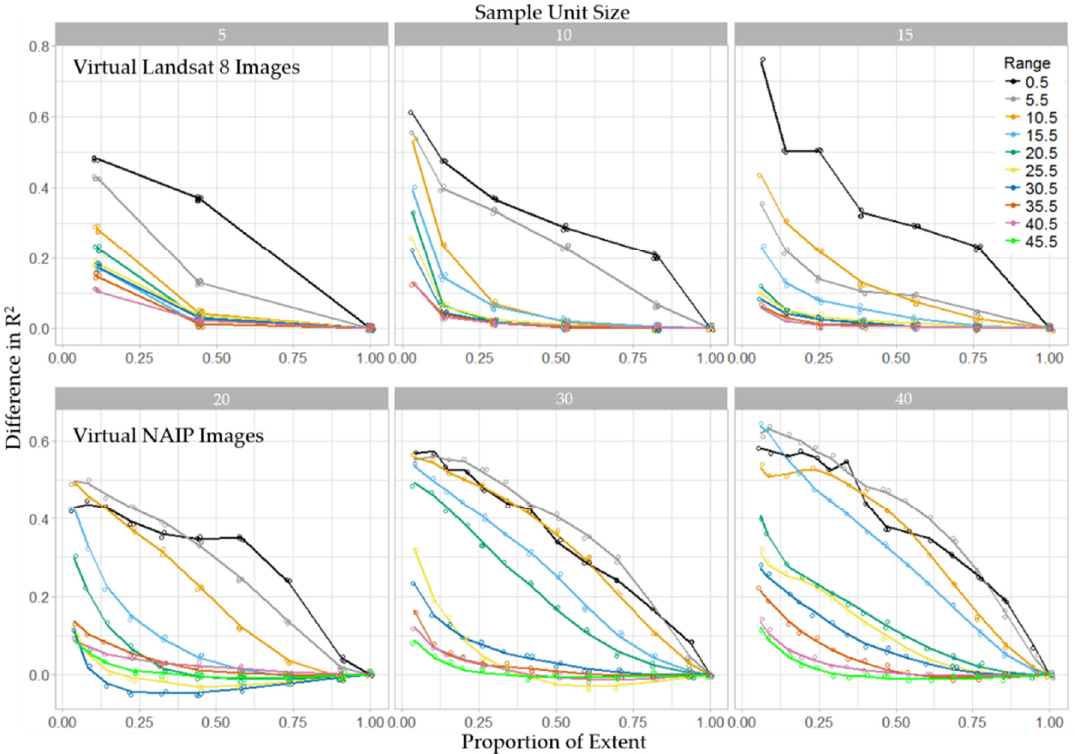
Figure 8. Reduction in the proportion of variation explained ( R 2 ) for Landsat 8 and NAIP virtual images by subsample intensity (Proportion of Extent), sample unit size (in cells), and spatial correlation (Range) using SYS 4 and P all subsampling layout. Figures A3 and A4 show actual Landsat 8 and NAIP image reductions.